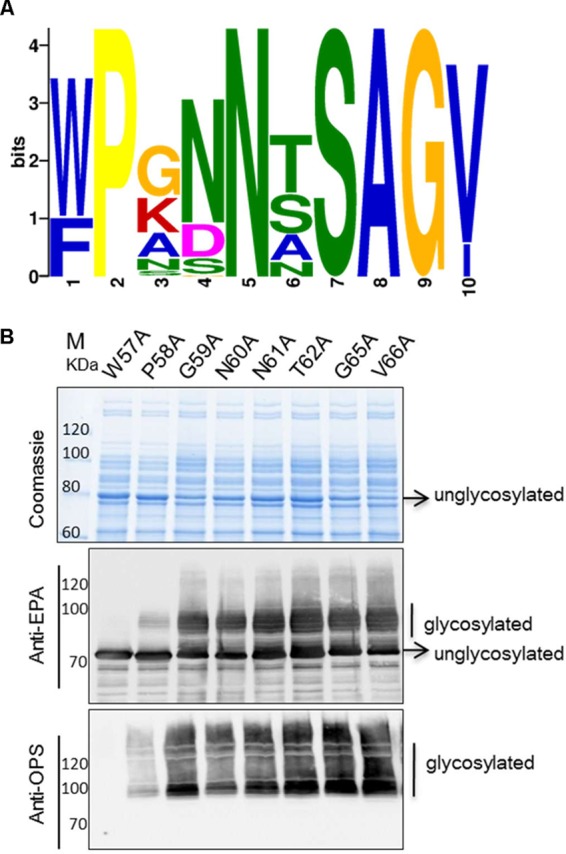
Analysis of the minimum recognition motif. (A) Conservation analysis of the 63 nonredundant PilE homolog sequences around S63 in Neisseria meningitidis (http://meme-suite.org/). (B) Alanine scanning of the glycosylated sequence. Plasmids containing these sequences were transformed into strain 301DWP, and glycosylation was detected by Western blotting.